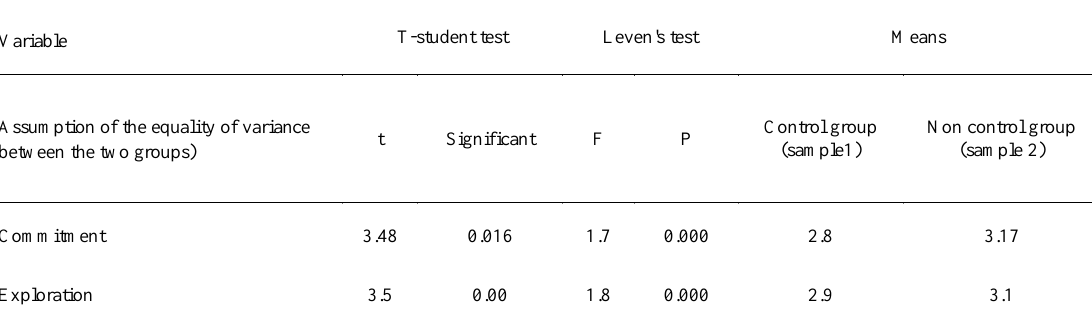
Table 1: Results of the data analysis